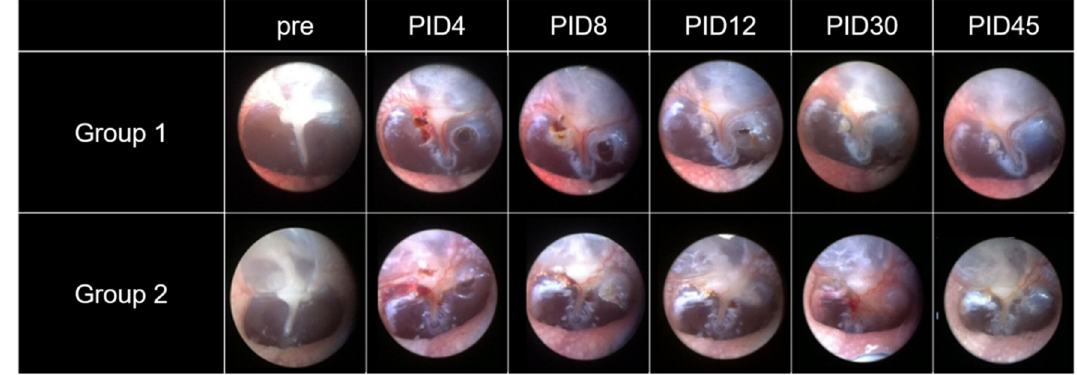
Figure 2. Visible light endoscopy of tympanic membrane perforations. Perforations that were generated during the injection procedure healed well in both groups. It took 13.2 ± 2.4 days for the perforation to heal completely in group 1 and 11.6 ± 4.0 days in group 2.